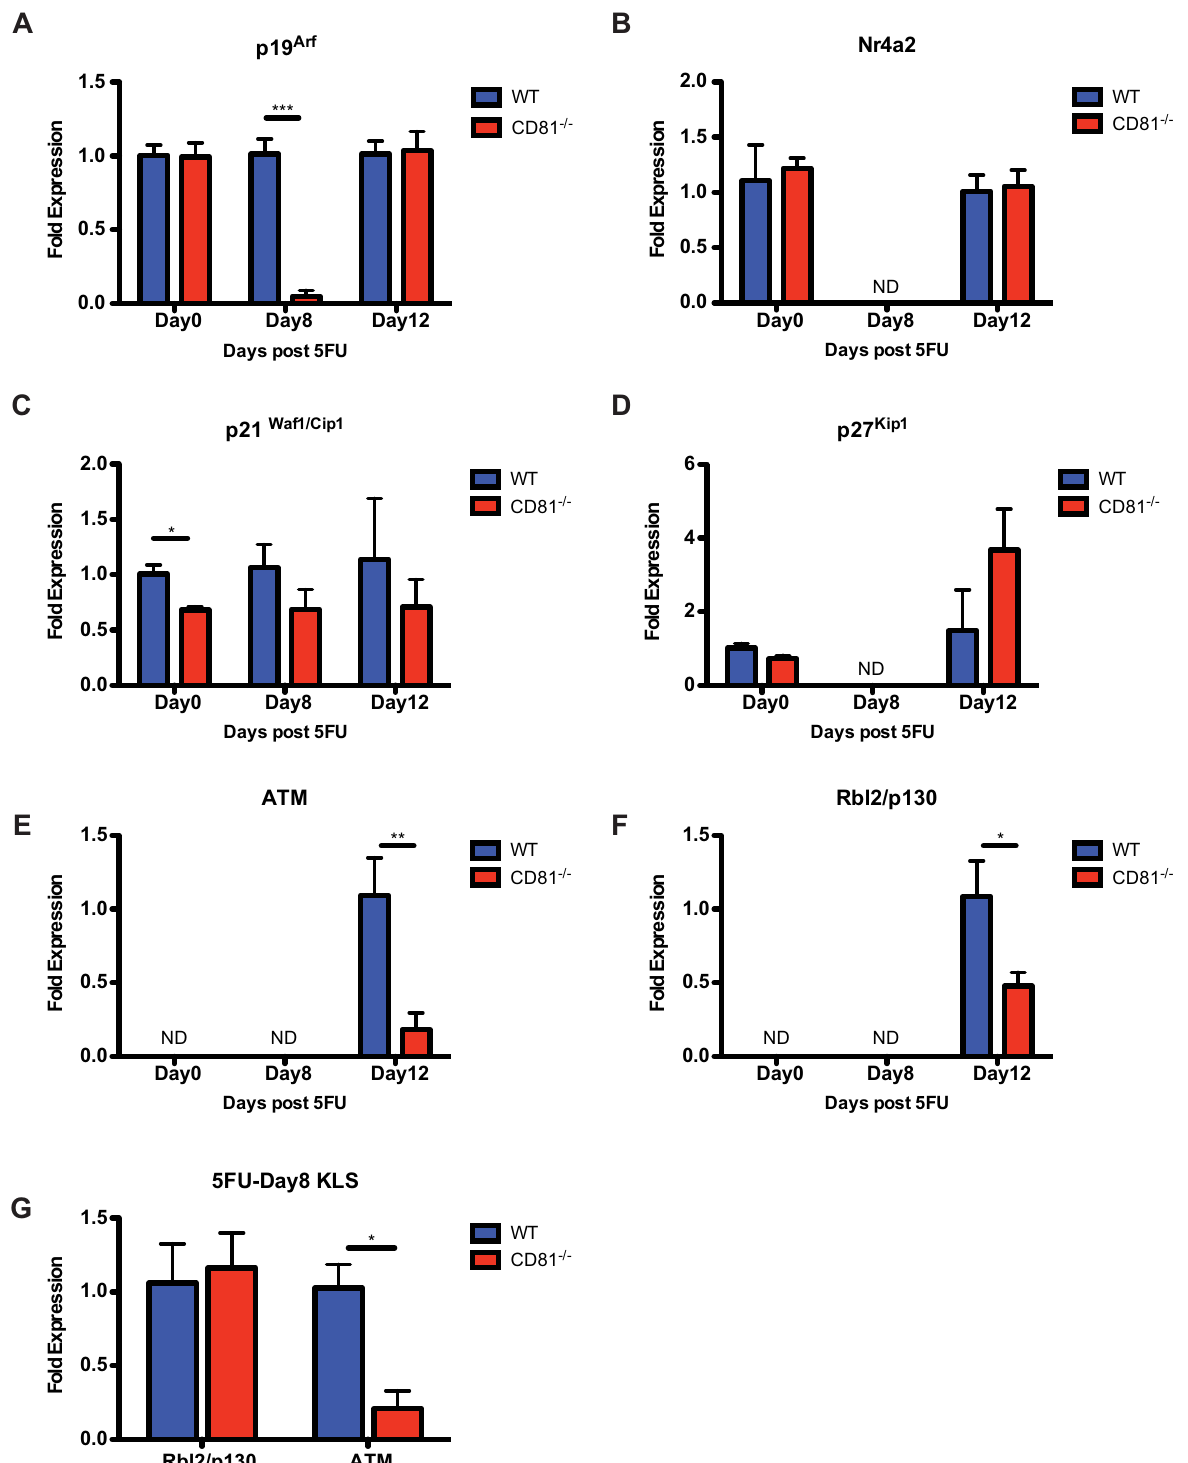
Figure 7. Cd81 2 / 2 HSCs exhibit low expression of CDK inhibitors and oxidative stress genes during homeostasis and regeneration. (A) Proliferating Cd81 2 / 2 HSCs (5FU-Day8) express a significantly lower level of p19 Arf while quiescent HSCs (those on 5FU-Day0 and 5FU-Day12) do not. (B) The expression of Nr4a2 is comparable in quiescent WT and Cd81 2 / 2 HSCs but not detectable in proliferating HSCs. (C) Cd81 2 / 2 HSCs in homeostasis present a significantly lower expression of p21 waf1/cip1 while those in regeneration do not. (D) The expression of p27Kip in both WT and Cd81 2 / 2 quiescent HSCs are comparable, albeit undetectable in proliferating HSCs. (E and F) The expression of Atm and p130 , the genes that respond to oxidative stresses, are only detectable in HSCs (250 to 300 cell equivalents) in a later stage of 5FU-regeneration (5FU-Day12). The expression of both Atm and p130 in Cd81 2 / 2 HSCs are significantly lower than those in WT HSCs. (G) On 5FU-Day8, the less primitive hematopoietic